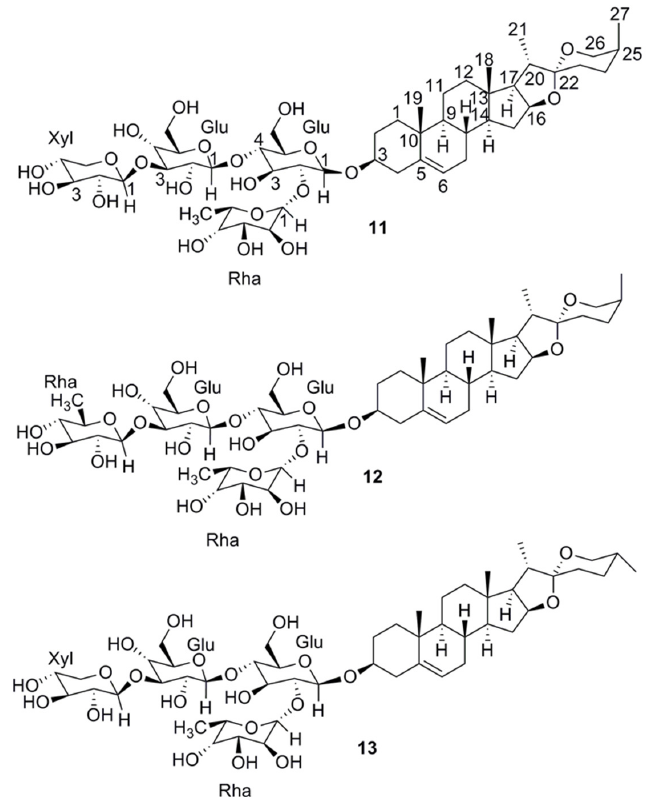
Figure 4. Chemical structures of ( 3 S, 20 S, 22R , 25 S)-spirost-5-en-3-yl-( β - D -xylopyranosyl-(1 → 3)- β - D - glucopyranosyl-(1 → 4) [ α - L -rhamnopyranosyl-(1 → 2)]- β - D -glucopyranoside ( 11 ), ( 3 S, 20 S, 22R , 25 S)- spirost-5-en-3-yl-( β - D -rhamnopyranosyl-(1 → 3)- β - D -glucopyranosyl-(1 → 4)[ α - L -rhamnopyranosyl-